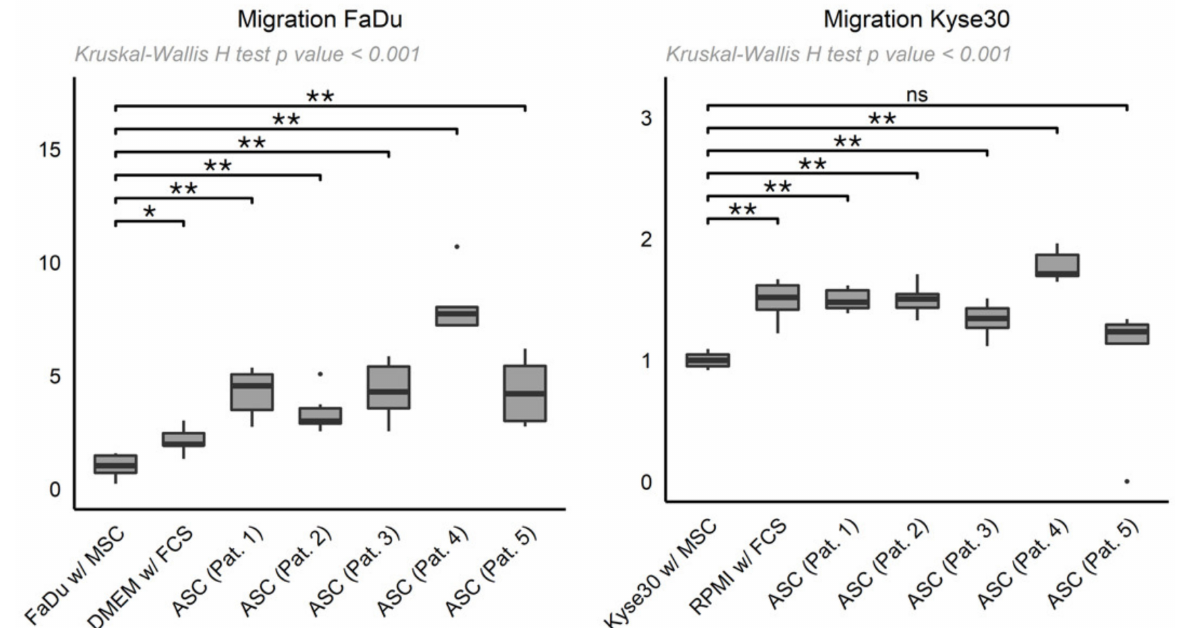
Figure 3. Box-whisker plots depicting migration (normalized after subtraction of negative controls) of FaDu ( left ) and Kyse30 cells ( right ) towards ASC-derived supernatants from patients 1–5 (“ASC (Pat. 1–5)”) or supernatant from FaDu/Kyse30 with MSCM (“FaDu w/ MSC”, “Kyse30 w/ MSC”), and DMEM/RPMI with FCS (“DMEM w/ FCS”, “RPMI w/ FCS”) as controls. Shown are mean ± SD from n = 3 independent experiments. Statistical test: Kruskal–Wallis H test, p -values * < 0.05, ** < 0.01, ns: not